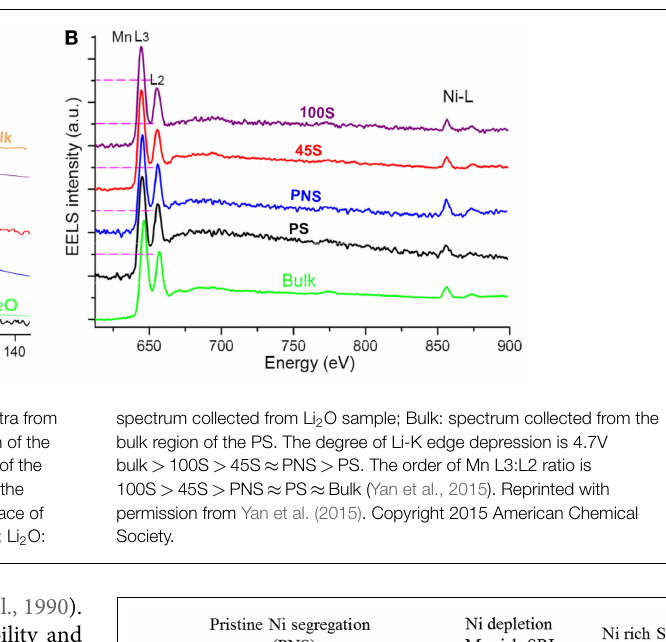
FIGURE 8 | (A) Low-loss EELS spectra and (B) high-loss EELS spectra from different samples. 4.7V bulk: spectrum collected from the bulk region of the 4.7V overcharged sample; 100S: spectra collected from the surface of the sample cycled 100 times; 45S: spectra collected from the surface of the sample cycled 45 times; PNS: spectra collected from the Ni-rich surface of PS; PS: spectra collected from the PS surface without a Ni-rich layer; Li 2 O: